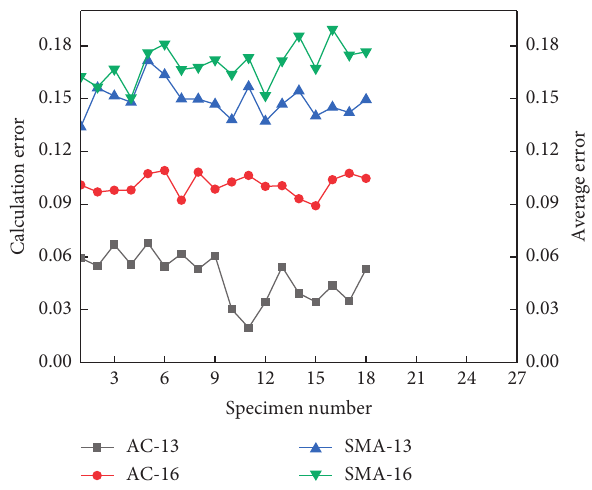
Figure 10: Applicability analysis of the Looyenga